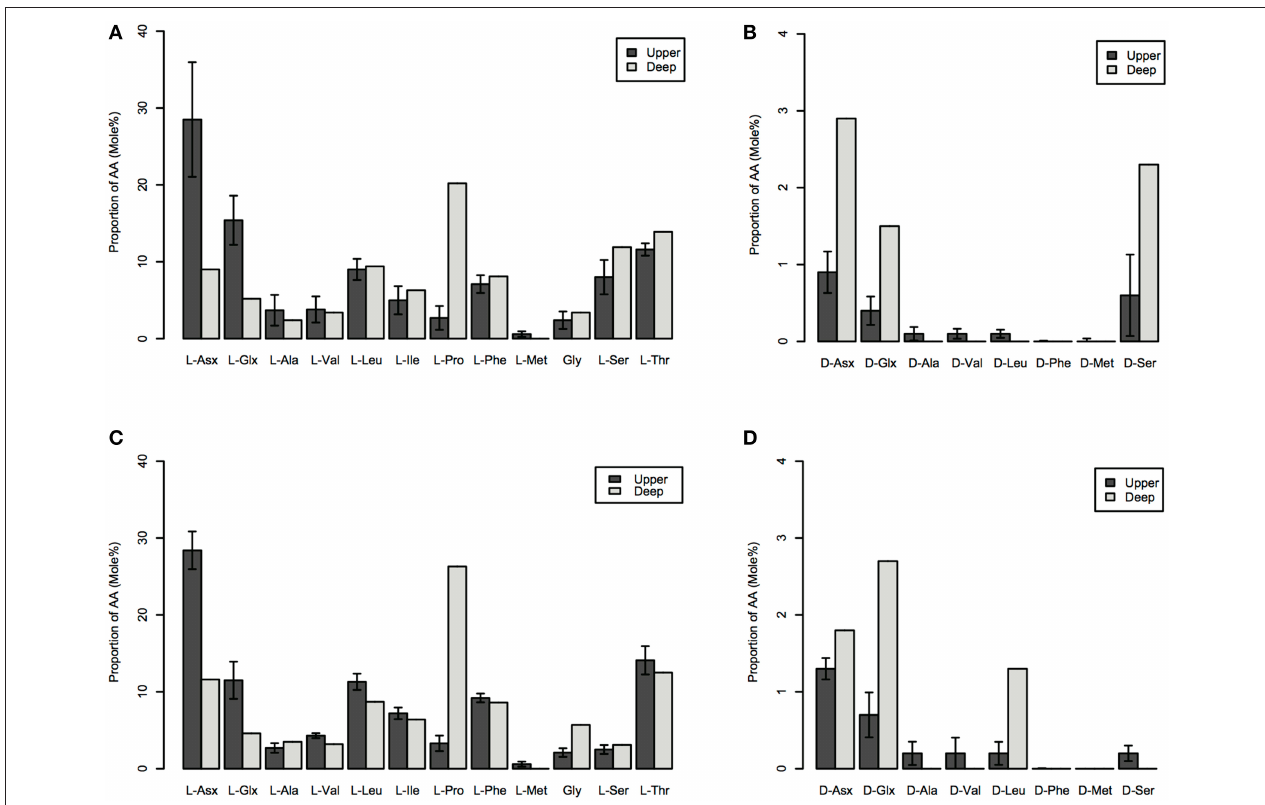
FIGURE 2 | Mole% of particulate AAs collected in the upper (10–200m) and the deep (at a depth of 1000m) layers of stations N (A,B) and S (C,D). AAs: L-Asx, L-aspartate and L-asparagine; L-Glx, L-glutamate and L-glutamine; L-Ala, L-alanine; L-Val, L-valine; L-Leu, L-leucine; L-Ile, L-isoleucine; L-Pro, L-proline; L-Phe, L-phenylalanine; L-Met, L-methionine; Gly, glycine; L-Ser, L-serine; L-Thr, L-threonine; D-Asx, D-aspartate and D-asparagine; D-Glx, D-glutamate and D-glutamine; D-Val, D-valine; D-Leu, D-leucine; D-Phe, D-phenylalanine; D-Met, D-methionine; and D-Ser, D-serine. The data for the upper layer are the average of the four layers (errors are standard